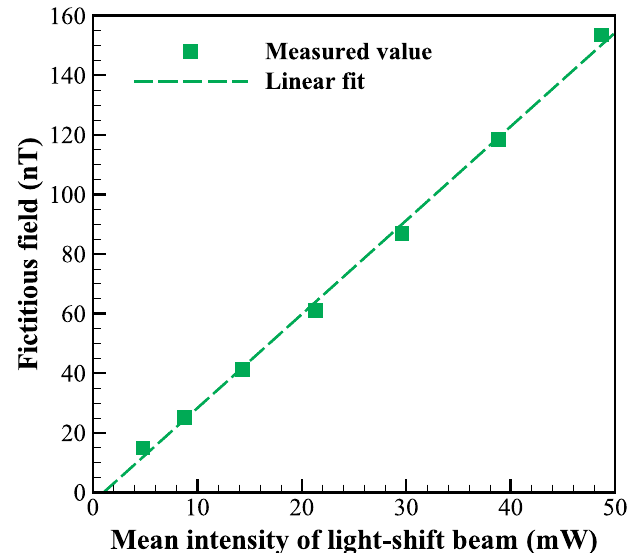
Figure 3. The relationship between the mean intensity of the light-shift beam with a wavelength of 1083.195 nm and the magnitude of the light-shift fictitious field. The square symbols are the measured values, and the dashed line is the corresponding linear